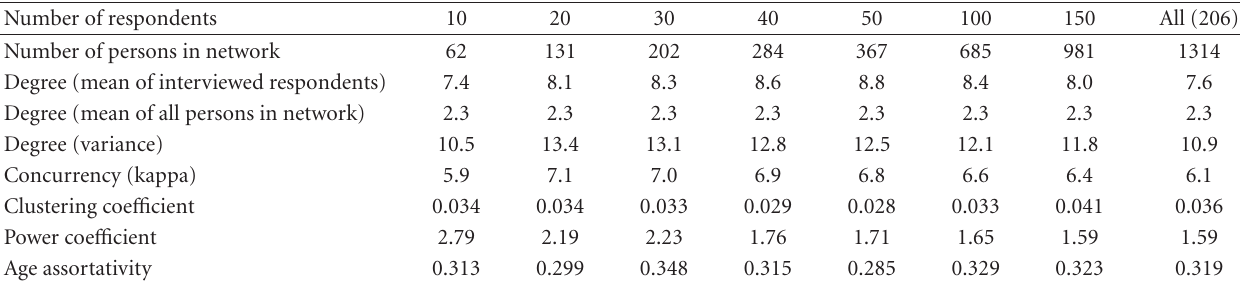
Table 1: Network features with chronological accrual of